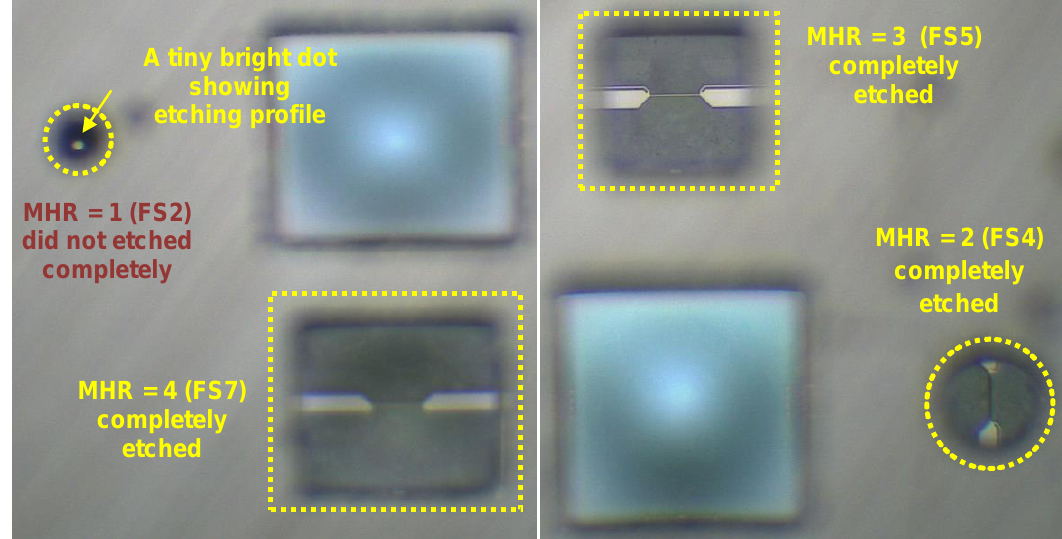
Figure 8. Optical micrograph of backside of the sensor chip, indicating the extent of etching for sensors with different MHRs . Hot-films are visible from the backside of the chip for MHR = 2, 3 and 4, indicating a complete etching. For MHR = 1, a tiny bright dot can be seen, indicating only a partial etching. For example, a polysilicon heater with dimensions 150 µ m × 3 µ m × 0.25 µ m and MHR =